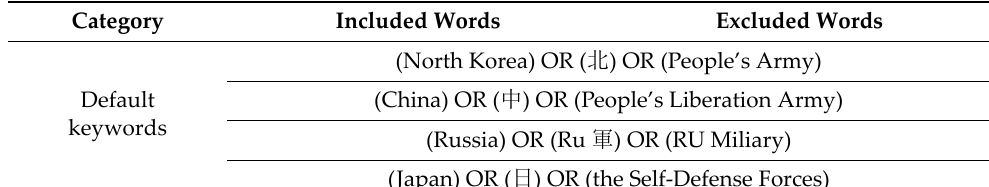
Table 3. Provocation act‑based Keywords (translated into